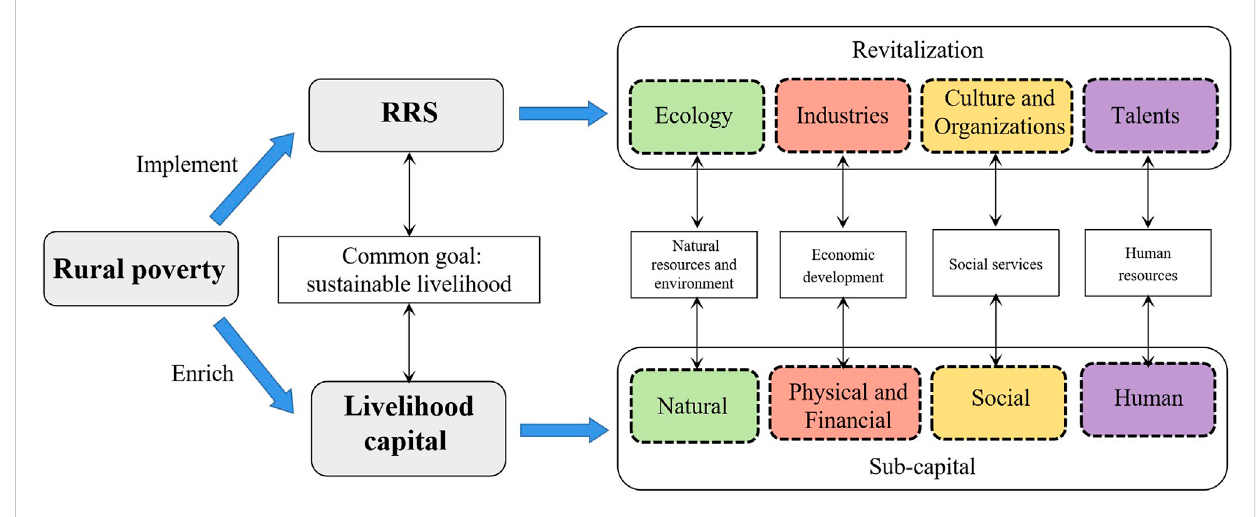
FIGURE 1 Links among rural poverty, the RRS, and livelihood